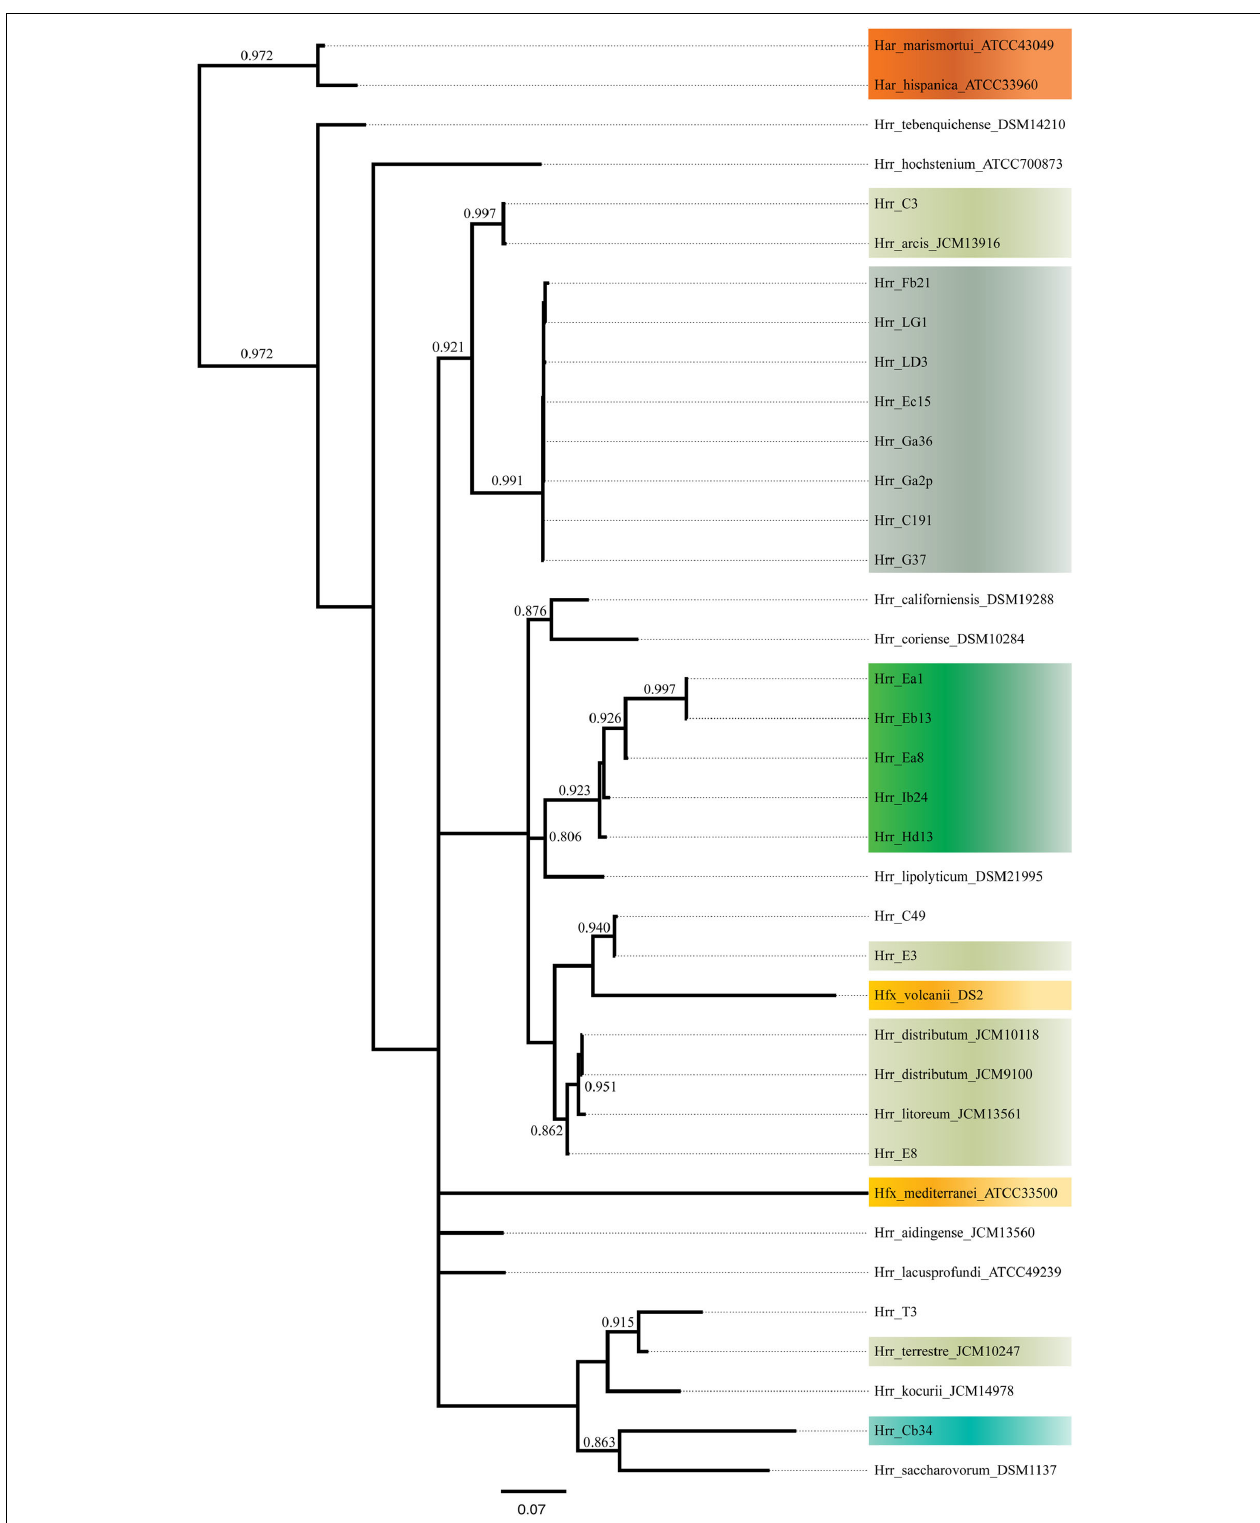
FIGURE 6 | Bayesian tree made from presence-absence of intein alleles and protein sequences of present alleles. Support values on branches are posterior probabilities. Posteriors below 0.8 are not displayed.